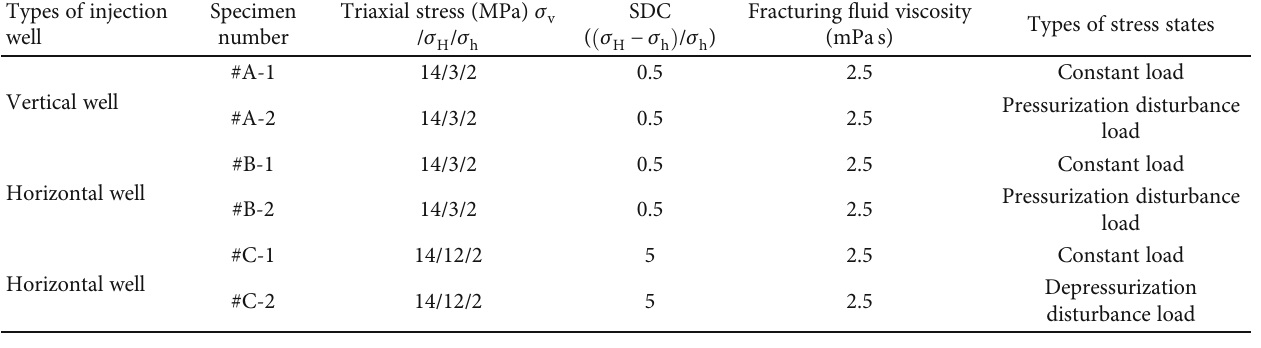
Table 1: Experiment program for hydraulic fracturing simulation of shale rock specimens.